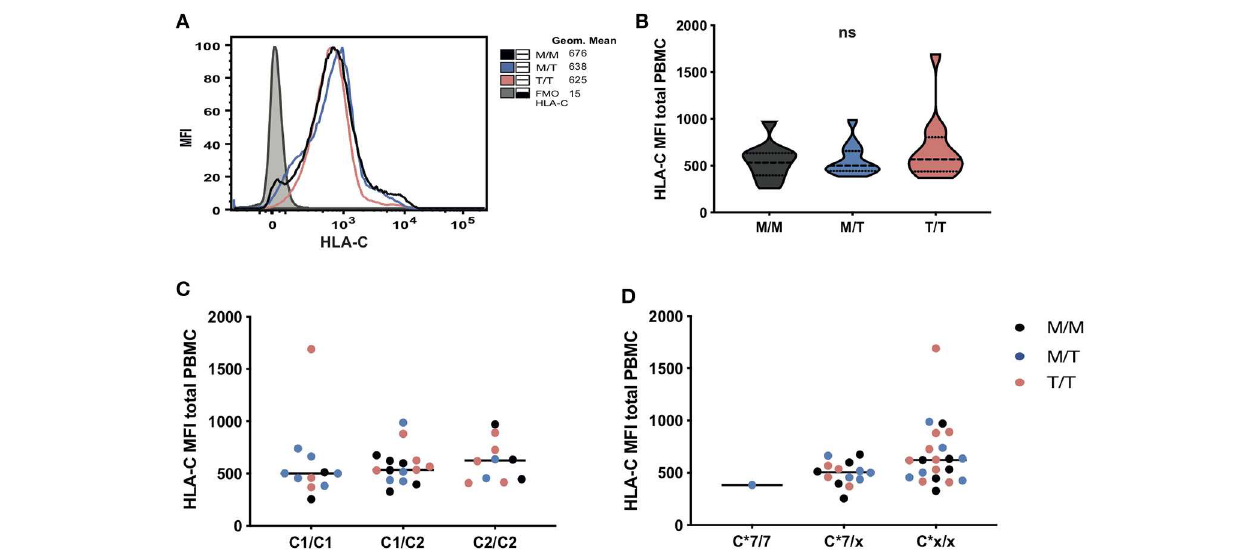
FIGURE 2 | No significant differences in HLA-C expression levels in subjects grouped according to -21 HLA-B dimorphism. (A) Representative histograms showing HLA-C expression (geometric mean fluorescence intensity (MFI) on total PBMC between groups as well as fluorescence minus one (FMO) control staining). Levels of surface expression of HLA-C (MFI of staining with antibody DT-9) on total PBMC in donors grouped: (B) by HLA-B -21 variant (data are shown as violin plots, and group median and quartiles are indicated); (C) according to HLA-C1 and C2 epitopes and (D) by the presence and absence of (x) of HLA-C*07. In panels (C) and (D) , M/M subjects are shown as black dots, M/T as blue dots and T/T as pink